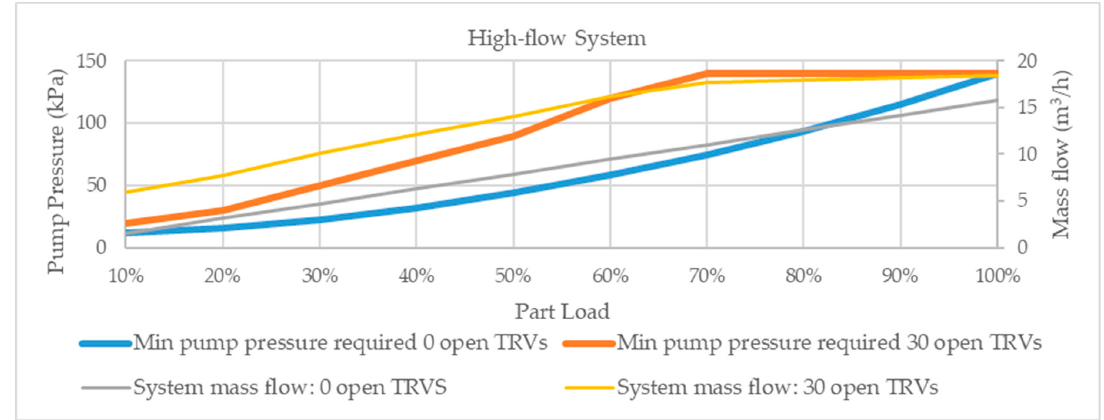
Figure 11. The minimum pump pressure difference required and the system mass flow rate for the operation without problematic TRVs and with one problematic TRV in each riser under high-flow system operation. Energies 2019 , 12 , 3215